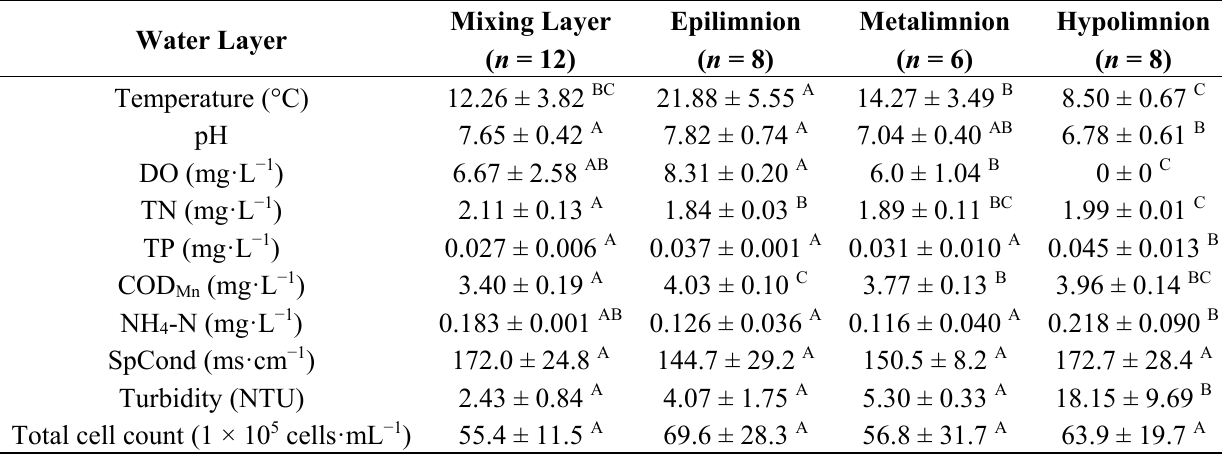
Table 1. Environmental parameters and total cell counts of the samples in the Jinpen Drinking Water Reservoir, China.